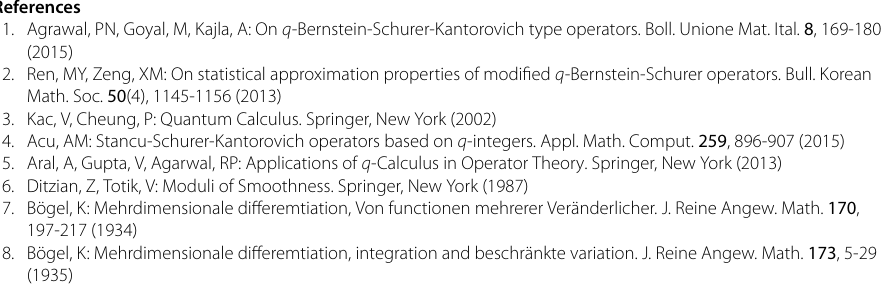
Figure 8 The comparison of rate of convergence of K ( α 1, α 2, β 1, β 2) n 1, n 2, p 1, p ( f ; q 1 , q 2 , x , y ) and T ( α 1, α 2, β 1, β 2) n 1, n 2, p 1, p 2 q 1 , q 2 , x , y ) to f ( x , y